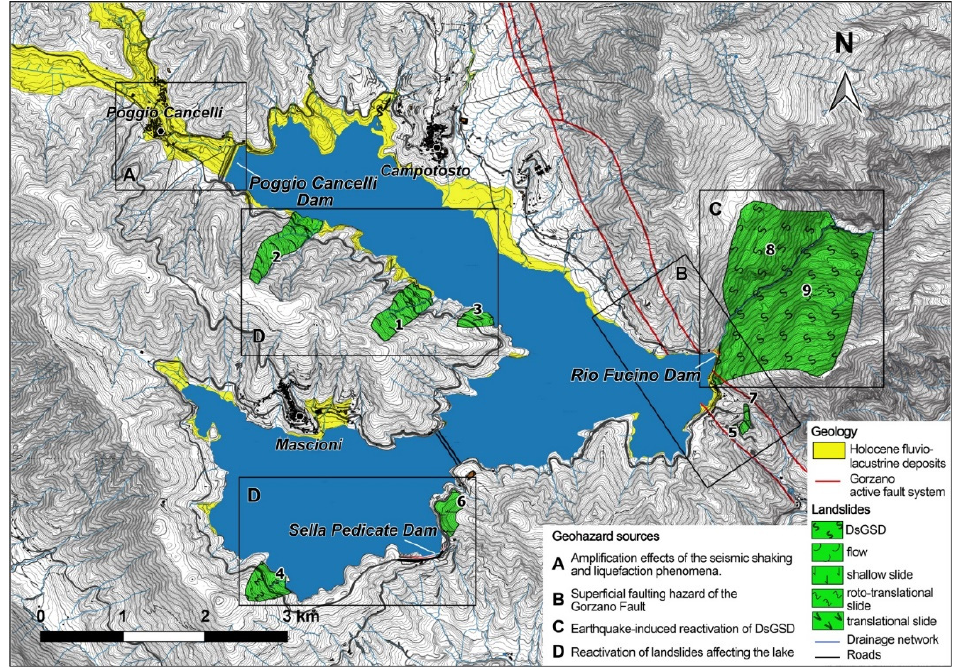
Figure 14. Map of the main seismically-induced hazards identified in the Lake Campotosto